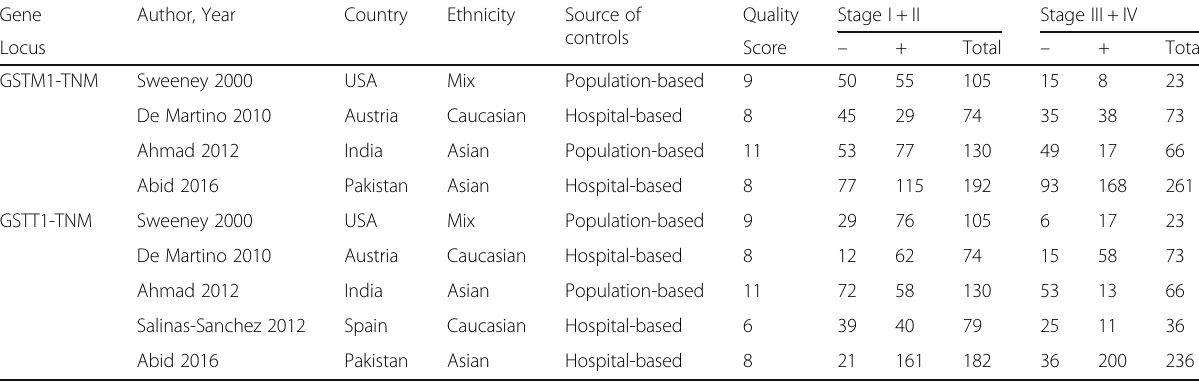
Table 3 Characteristics of studies evaluating the effects of GSTM1 and GSTT1 null genotypes on clinical TNM stages of RCC